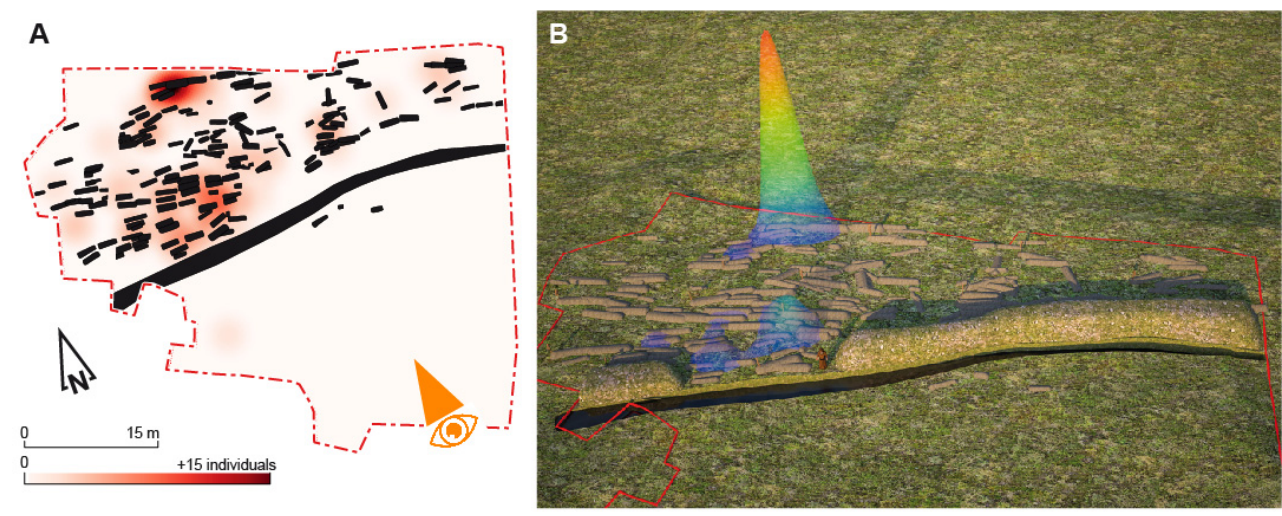
Figure 10. Heatmap representing the concentrations of individuals in secondary positions. Heat map in plan ( A ) and 3D ( B ). The eye indicates the direction angle for the 3D restitution.